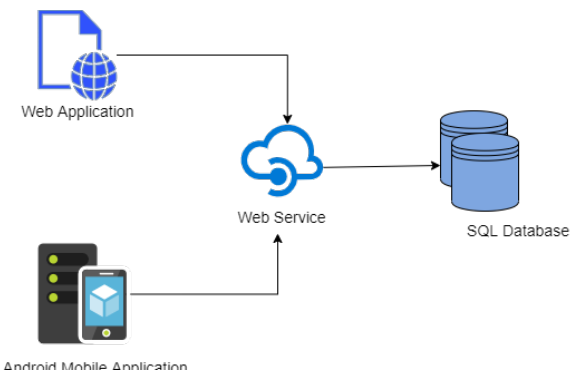
Figure 1. System